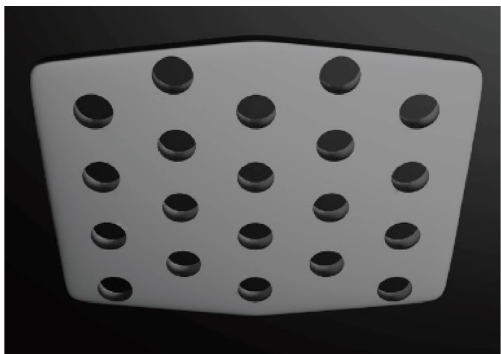
Figure 2: Perforated base design.